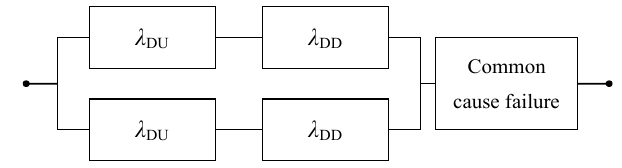
entire 1oo2 system [4,36,38].